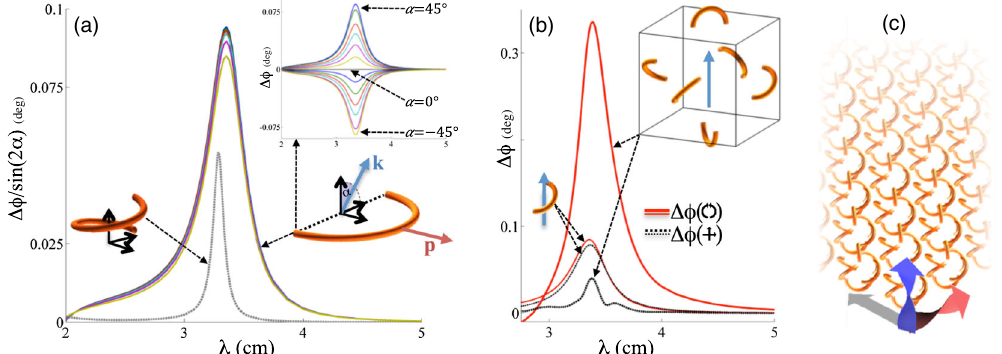
FIG. 3. Optical activity and the design of an optically active mirror-symmetric array of conducting scatterers. (a) The optical activity (relative phase delay between right and left circular polarizations) of a semicircular conducting wire calculated numerically at varying angles of incidence and plotted against the exciting wavelength (see Appendix A). The inset shows the rotation angle (cid:1) (cid:10) as a function of the exciting frequency, where different curve colors correspond to different orientations, as described below. The main panel shows the collapse of the rotation angle curves when rescaled by sin ð 2 (cid:2) Þ . The peak response is observed at a wavelength (cid:11)= 2 (cid:5) l , where l (cid:5) (cid:9)= 2 cm is the length of the scattering wire. The orientation of the semicircles is prescribed by a director (axis) that joins the semicircle’s ends (dotted line) and a polar vector p perpendicular to the director and pointing to the midpoint of the semicircle. The angle of incidence, (cid:2) , is measured between the incident k vector and the normal to the semicircle. (cid:2) is varied by rotating the semicircle about its polar vector, and it takes the values (cid:1) 45 , (cid:1) 30 , (cid:1) 20 , (cid:1) 15 , (cid:1) 10 , (cid:1) 5 , and 0. The strong angular dependence of the response amplitude (inset) is predicted by (1) to scale as sin ð 2 (cid:2) Þ at all wavelengths, as observed by the collapse of the rescaled curves. The optical activity of a single period of a helix of the same length is given for comparison (dashed curve). The small discrepancy between the rescaled curves is due to a small fourth-order tensor correction, which can be calculated explicitly. See Sec. VI. (b) To reduce linear birefringence of a single scatterer (thin black curve) while retaining its optical activity (thin red curve), we make use of the tensorial form of the optical activity (see Table I, the symmetry arguments). This allows a mirror-symmetric arrangement of six semicircles on the faces of a cube such that both their directors and polar vectors are isotropically distributed while retaining a constructive handed response. The relative magnitude between the resulting optical activity (thick red curve) and the linear birefringence (thick black curve) is reduced by a factor of about 8. As the handedness tensor of the array of scatterers possesses the same symmetry properties as that of the single scatterer, an array of such arrays may be constructed to further diminish linear effects. Successive iteration will result in a hierarchical arrangement of scatterers exhibiting an exponential (in the iteration number) attenuation of linear birefringence and dichroism effects. (c) A section from an optically active metamaterial sheet, where each scattering unit is made from six semicircular scatterers arranged as described in (b). The helical arrows denote the principal directions of optical